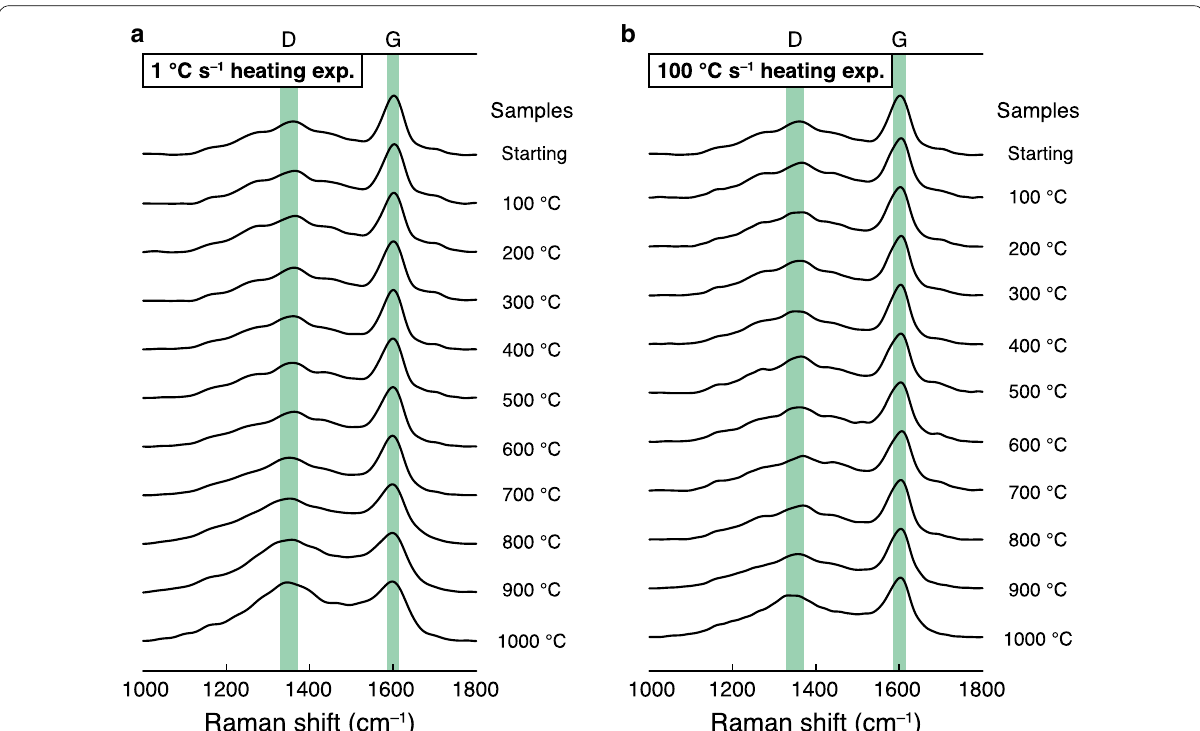
Fig. 3 Representative Raman spectra of the analyzed CM. Raman spectra of CM from shale and from products heated at a rate of a 1 °C s − 1 or b 100 °C s − 1 . exp . experiment